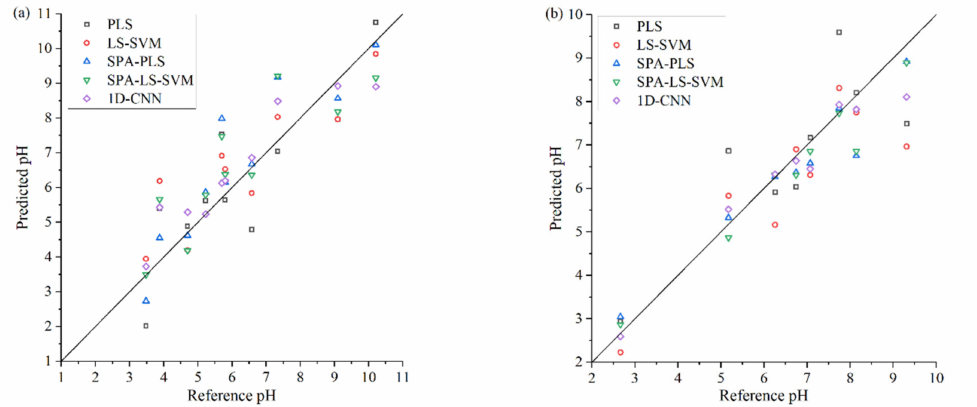
Figure 9. Scatter plots of reference pH and the predicted pH obtained by different regression models: ( a ) spectrophotometer experiment; ( b ) grating spectrograph experiment. The solid line in each figure represents the ideal regression